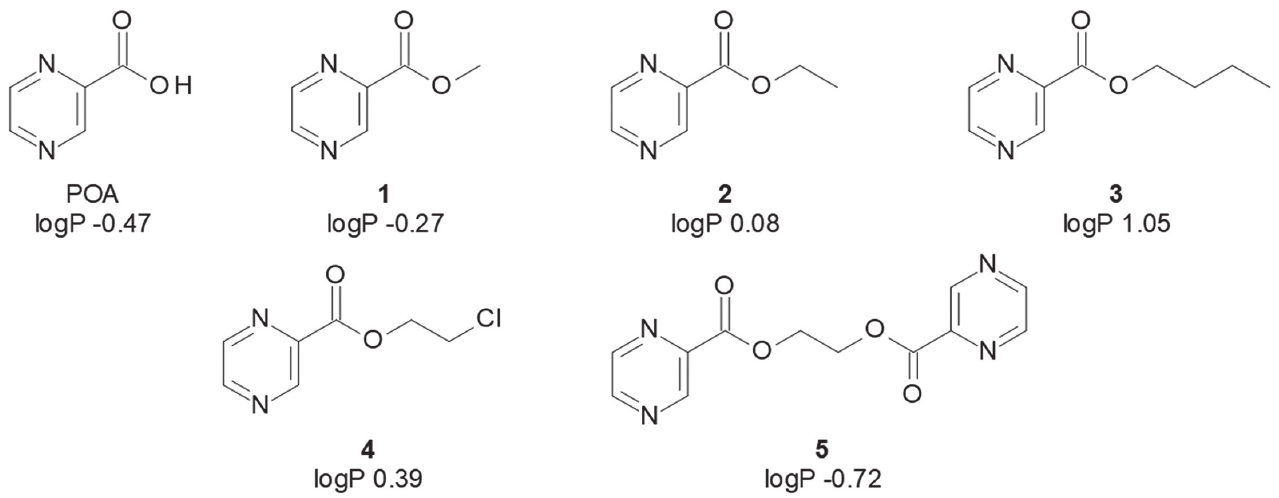
FIGURE 2 - Chemical structure of the pyrazinoic acid (POA) and their derivatives 1 - 5 evaluated in this work, and respective experimental values of partition coefficient (log P) as quantitative measure of the